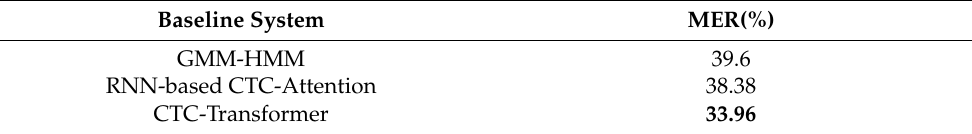
Table 2. MER(%) of different framework CSSR baseline systems.